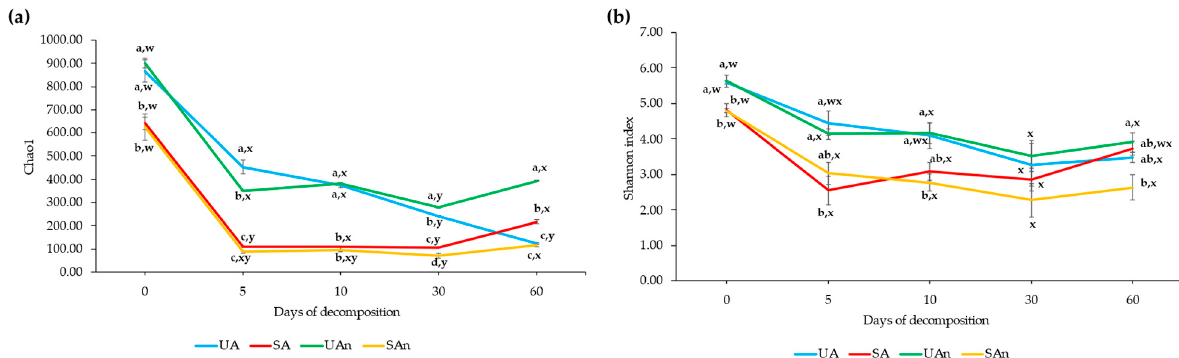
Figure 3. Alpha diversity indices of decomposing poultry carcasses in different burial set-ups decomposed for 60 days. ( a ) Chao1 and ( b ) Shannon index. UA, SA, UAn, and SAn represent unsterilized soil–aerobic condition, sterilized soil–aerobic condition, unsterilized soil–anaerobic condition, and sterilized soil–anaerobic condition, respectively. The 0, 5, 10, 30, and 60 represent the sampling period. ANOVA was used to test for the overall comparison of the Chao1 and Shannon among the burial set-ups on days 0, 5, 10, 30, and 60 of decomposition. Different letters in the figure ( a – d ) indicate the significant differences ( p < 0.05) between burial set-ups at each sampling day, while (w–z) indicate the significant differences ( p < 0.05) between the sampling period of each burial set-up.